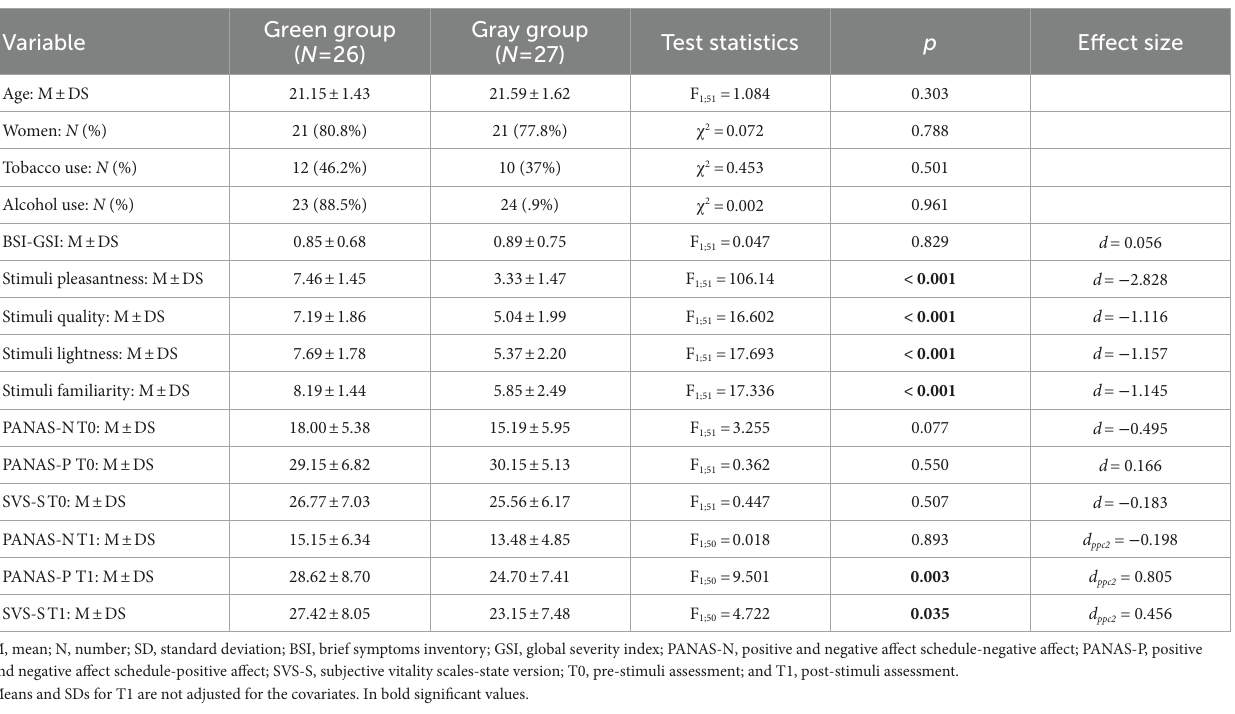
TABLE 2 Detailed descriptive and F statistics.